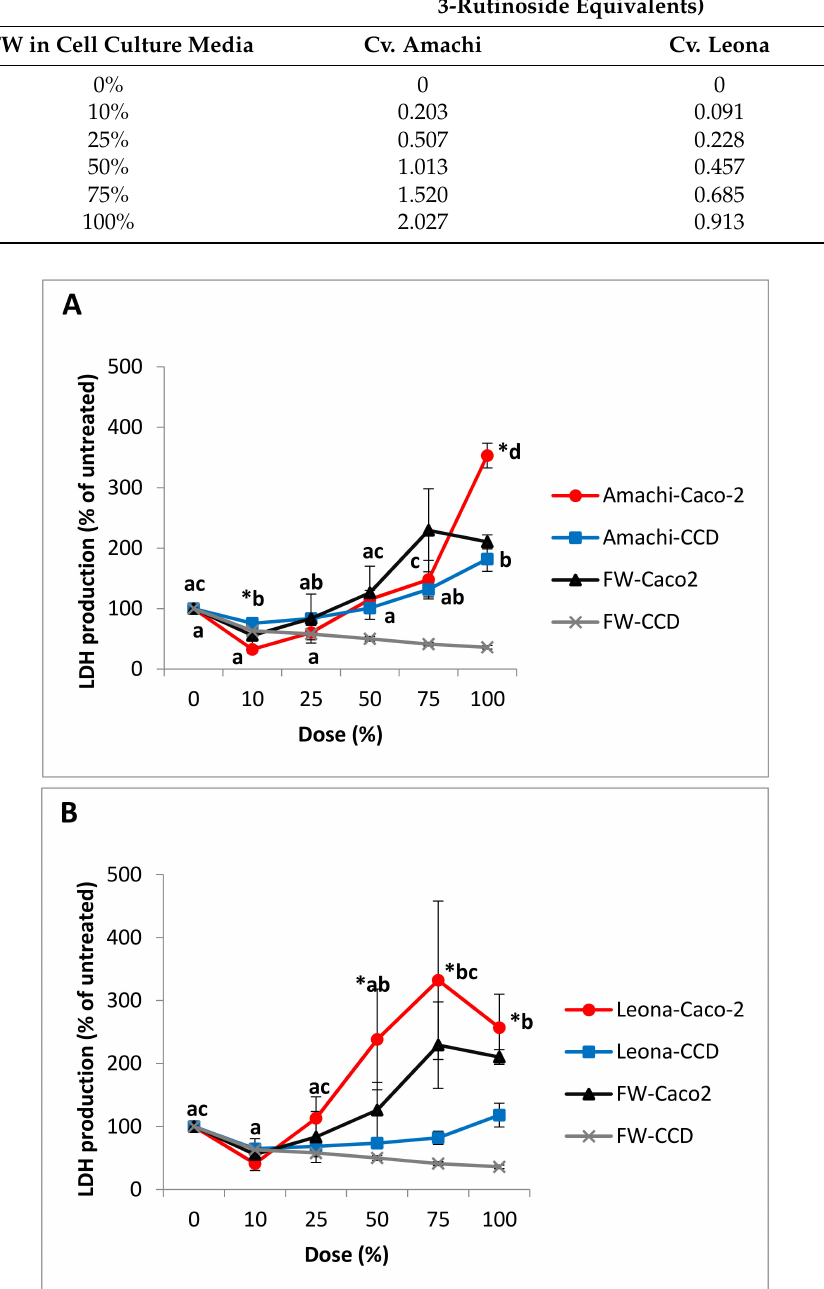
Figure 3. Effect of in vitro digests of cvs. Amachi ( A ) and Leona ( B ) on LDH production by Caco-2 and CCD-112CoN cells. Values are means ± SE of four independent experiments. Statistical analysis was performed via two-way ANOVA using cell line (Caco-2 versus CCD-112CoN) and dose (0%, 10%, 25%, 75% and 100%) as factors. Within each cell line, mean LDH values without a common letter are significantly different ( p < 0.05). Between cell lines and within each dose, the symbol * represents a significant difference ( p < 0.05) in the comparison between Caco-2 and CCD112-CoN cells at a specific digest